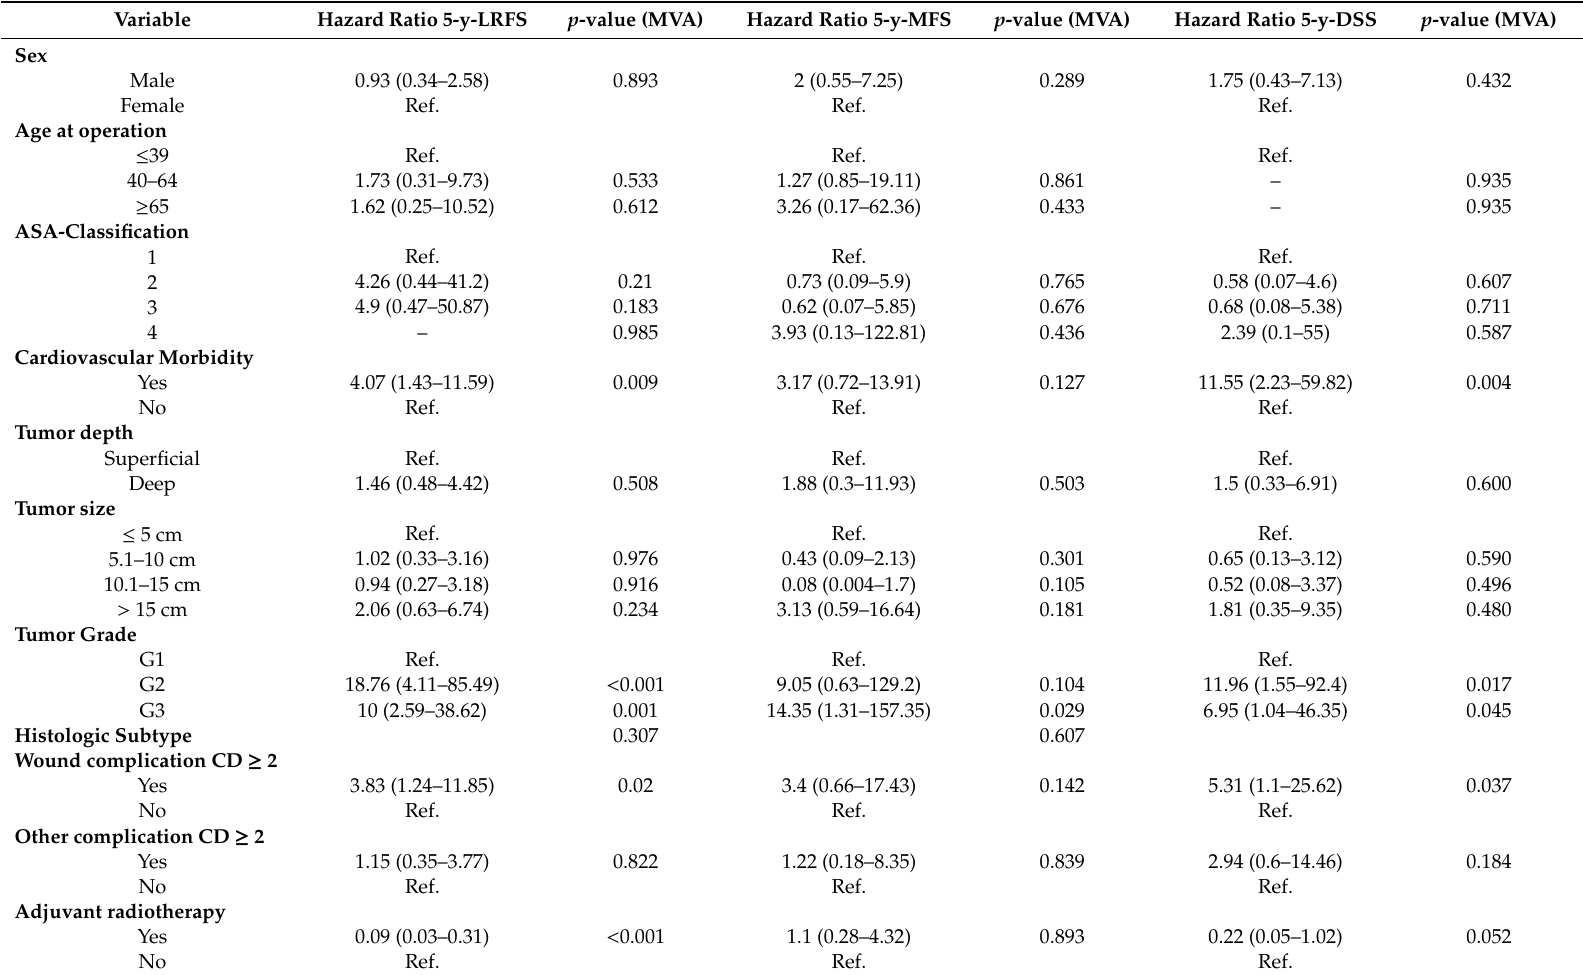
Table 4. Multivariate analysis of factors associated with 5-y LRFS, MFS, and